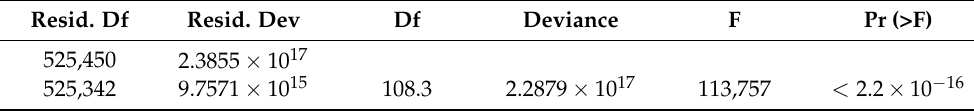
Table 12. Analysis of deviance